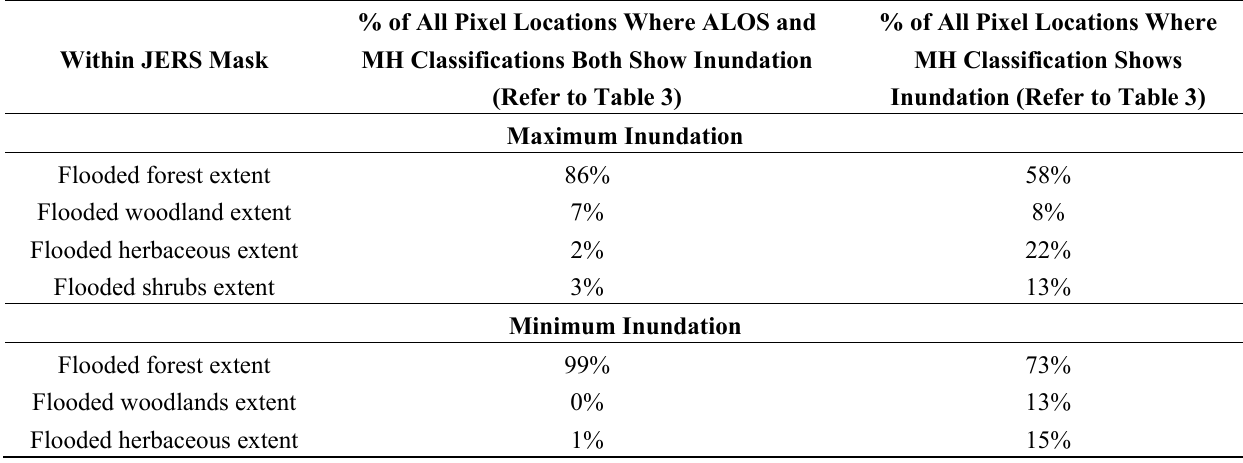
Table 4. Comparison of ALOS classification results from Figure 7 and Melack and Hess (MH) classification results (from [4])) for two cases: for those locations where both classifications indicated an inundation class and for those locations where the JERS-1 classification alone indicated an inundation